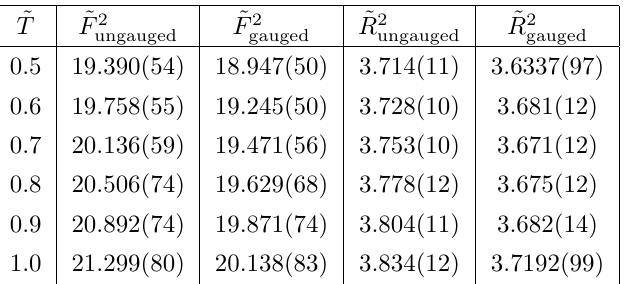
Table 3. Data for the potential energy term ~ F 2 and the extent of space ~ R 2 of the ungauged and gauged theories at the largest N available for each ~ T and in the continuum limit. N = 32 for all temperatures in the ungauged theory, and for the lowest temperature in the gauged theory, but N = 24 for ~ T 0 : (cid:21)